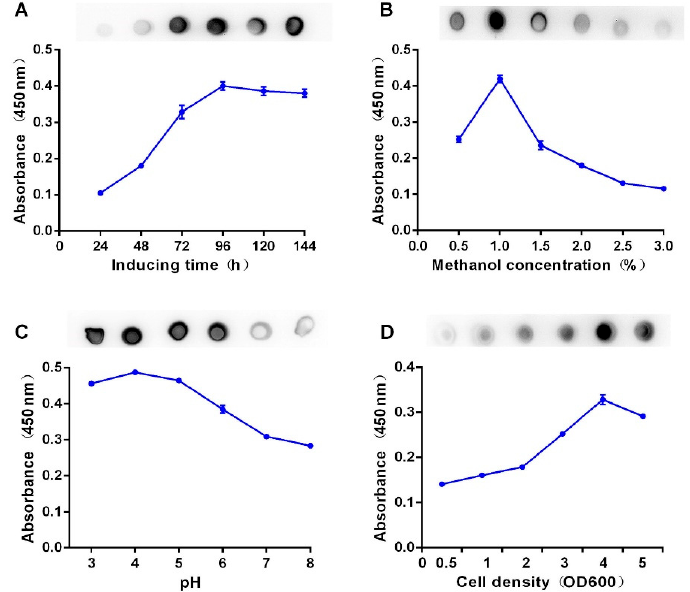
Figure 4. Optimization of recombinant BsDb expression in Pichia pastoris . Supernatants collected at each evaluated condition were analyzed using ELISA and spot Western blotting analysis. ( A ) Optimization of the methanol inducing time, ( B ) optimization of the methanol concentration, ( C ) optimization of the pH value, and ( D ) optimization of the cell density. The experiment was performed in triplicate, and the mean values ± SD were presented.